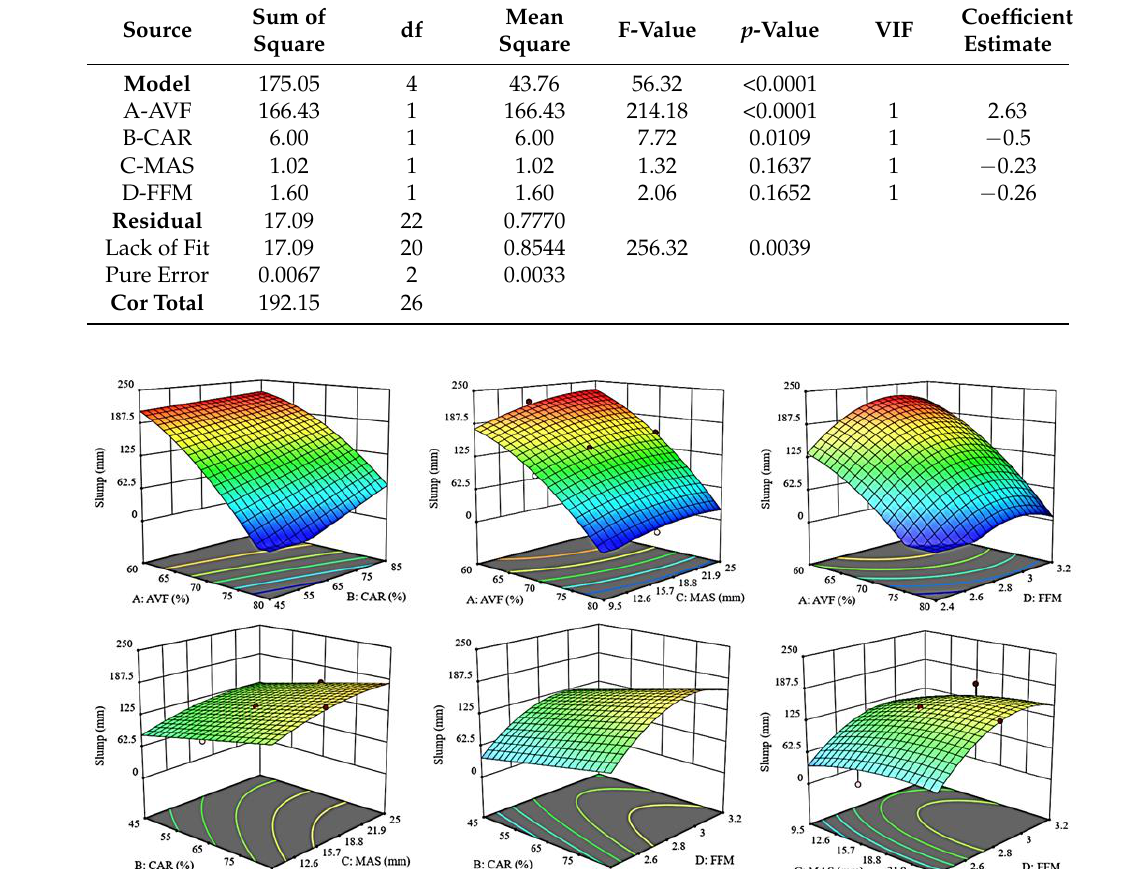
Figure A1. Response surface of slump model.